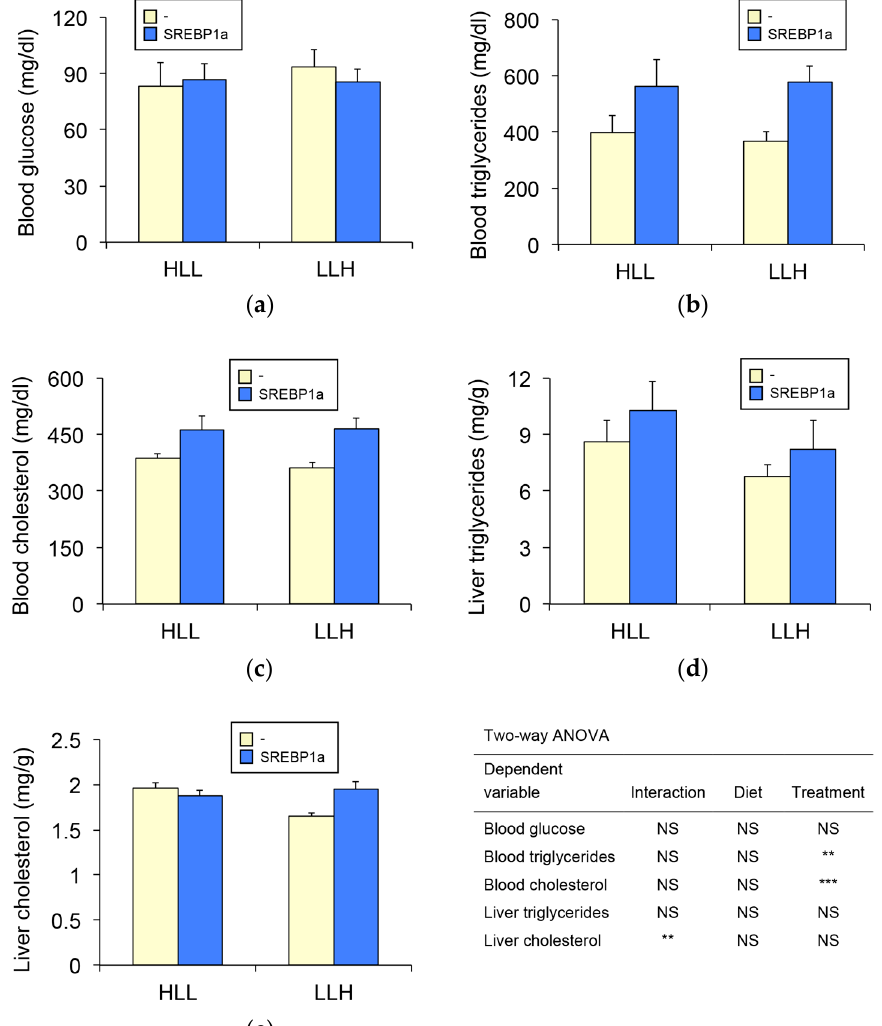
Figure 2. Effect of chitosan-TPP-pSG5-SREBP1a administration on serum and liver metabolite levels in S. aurata . Twenty-four h after the last meal, fish fed diet HLL or LLH were intraperitoneally administered with chitosan-TPP nanoparticles complexed with 10 μ g/g BW of pSG5 (-) or pSG5-SREBP1a (SREBP1a). Seventy-two hours following the treatment, the liver and blood were collected. The levels of blood glucose ( a ), blood triglycerides ( b ), blood cholesterol ( c ), liver triglycerides ( d ) and liver cholesterol ( e ) are presented as mean ± SEM ( n = 6–9). Statistical significance for independent variables (diet and treatment) is indicated as follows: ** p < 0.01; ***p < 0.001; NS not significant.